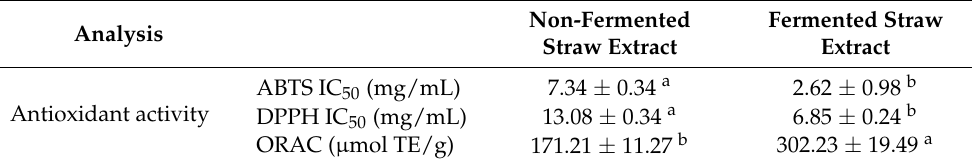
Non-Fermented Fermented Straw Straw Extract Extract